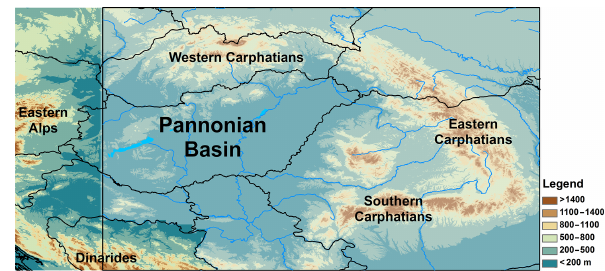
Figure 1. The Pannonian Basin with major orographic and river systems. The area of CarpatClim dataset is